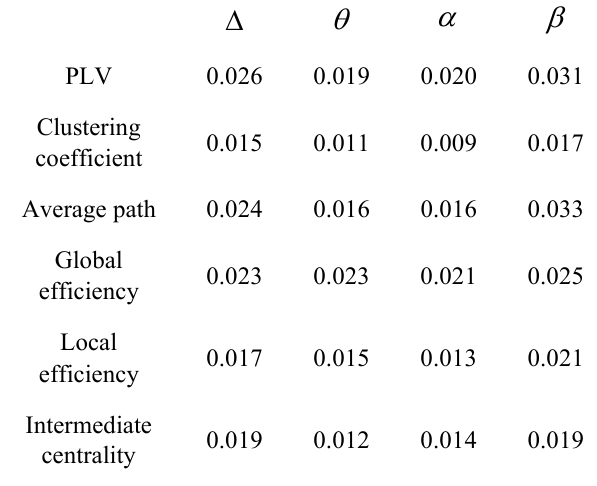
Figure 8. The PLV matrixes of the tristimania and control groups.